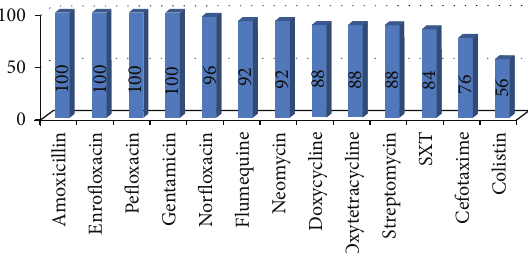
Figure 5: Antimicrobial resistance percentages of E. coli isolates to 13 antimicrobials tested individually using disc diffusion